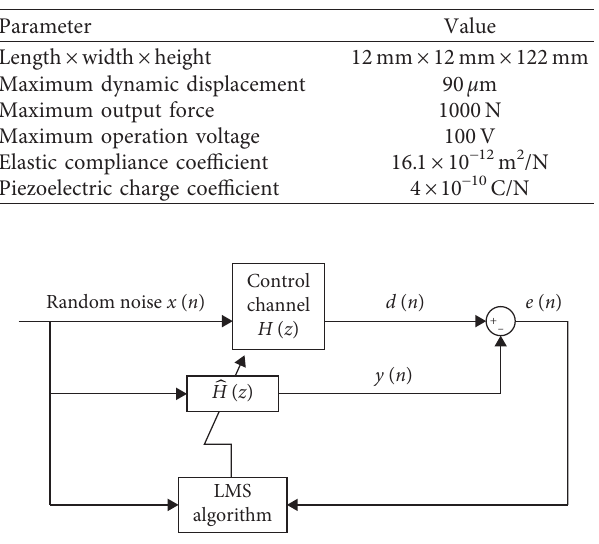
Figure 5: Schematic diagram of the control channel offline